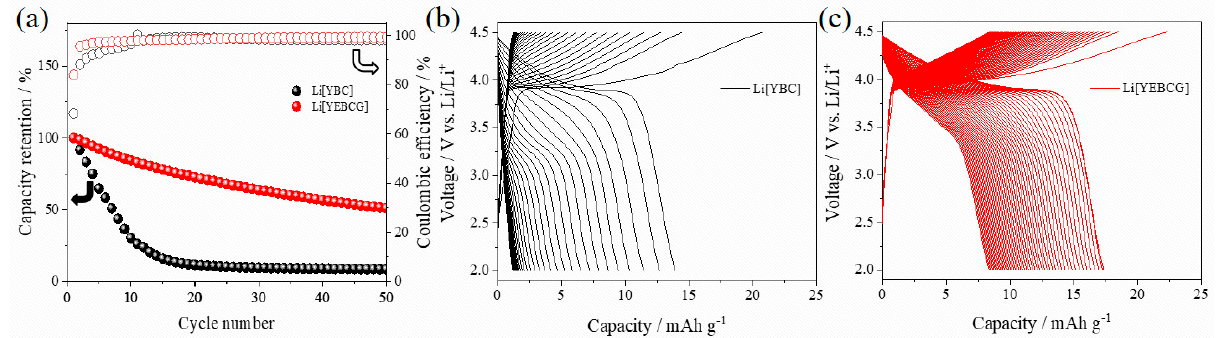
Figure 5. ( a ) Capacity retention at 0.1 C with Coulombic efficiency, and corresponding voltage profiles of ( b ) YBC and ( c ) YEBCG during 50 cycles.